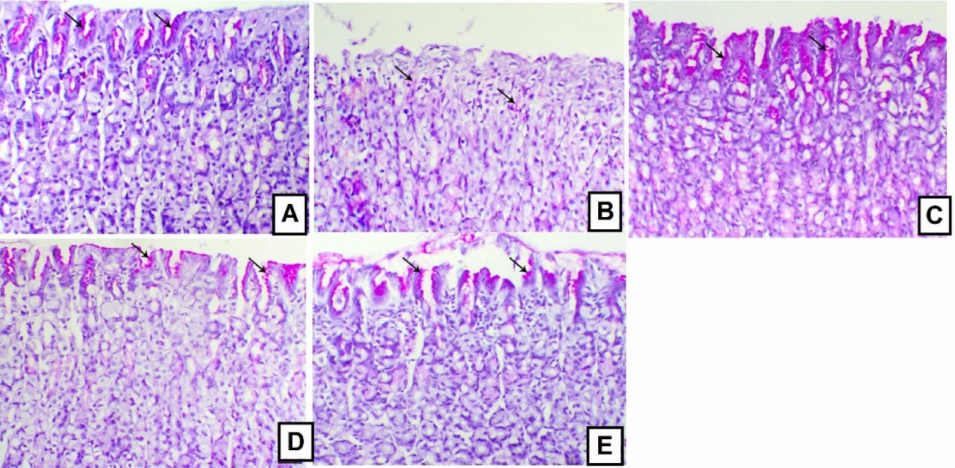
Figure 5. A photomicrograph of a stomach. ( A ) Control group displaying normal glycoproteins secretion within the mucosal lining of the gastric pits of the gastric glands (arrows); ( B ) indomethacin group showing a marked decrease of glycoproteins within gastric mucosa (arrows); ( C ) famotidine-treated group showing a marked increase of glycoproteins within the gastric glands (arrows); ( D ) A. anthelmintica extract (200 mg/kg)-treated group showing an increase of glycoprotein content within the gastric glands (arrows); ( E ) A. anthelmintica extract (100 mg/kg)-treated group showing an increase of glycoproteins within the covering mucosa of the gastric glands (arrows), PAS stain, 200 × , bar = 50 µ